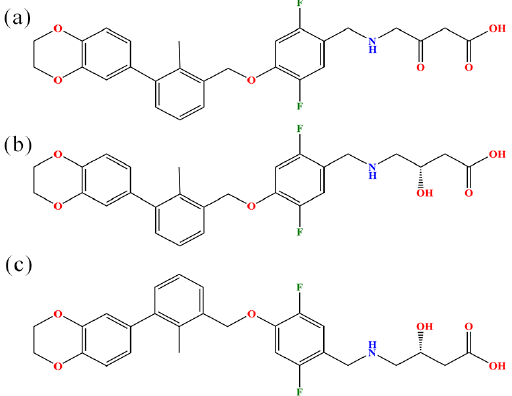
Figure 1. Chemical structural formulas of ( a ) (MOD)-BMS-200, ( b ) (S)-BMS-200 and ( c ) (R)-BMS- 200.